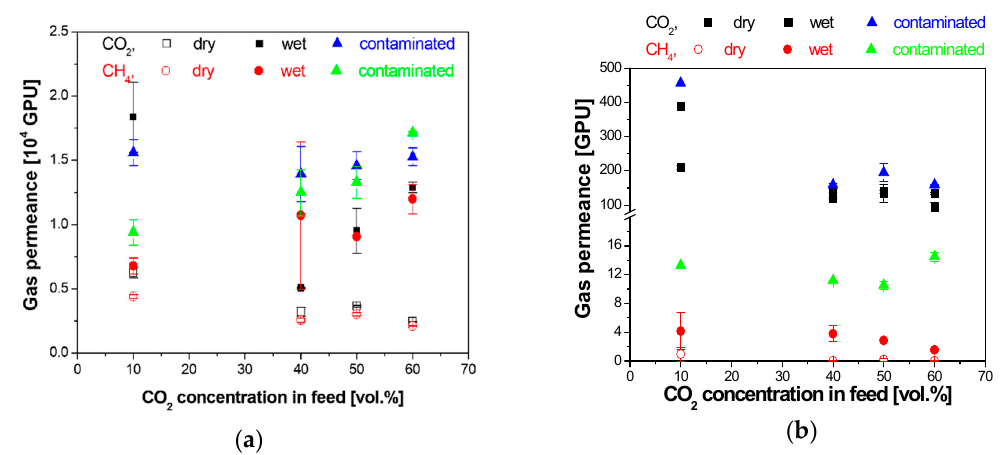
Figure 3. Influence of dry (void symbols) and humid (full symbols) conditions of the feed in the CO 2 (black squares) and CH 4 (red circles) permeance through the hydrophobic PDMS ( a ) and the hydrophilic IL–CS flat composite membrane ( b ). Data obtained after contamination with the toluene solution are drawn by the full triangles (blue for CO 2 , and green for CH 4 ).